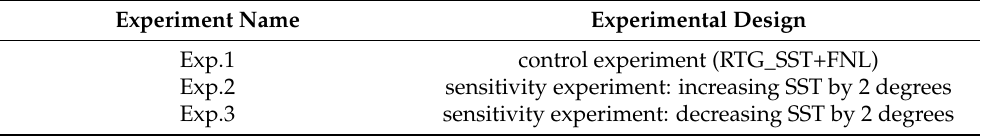
Table 1. Numerical simulation experimental